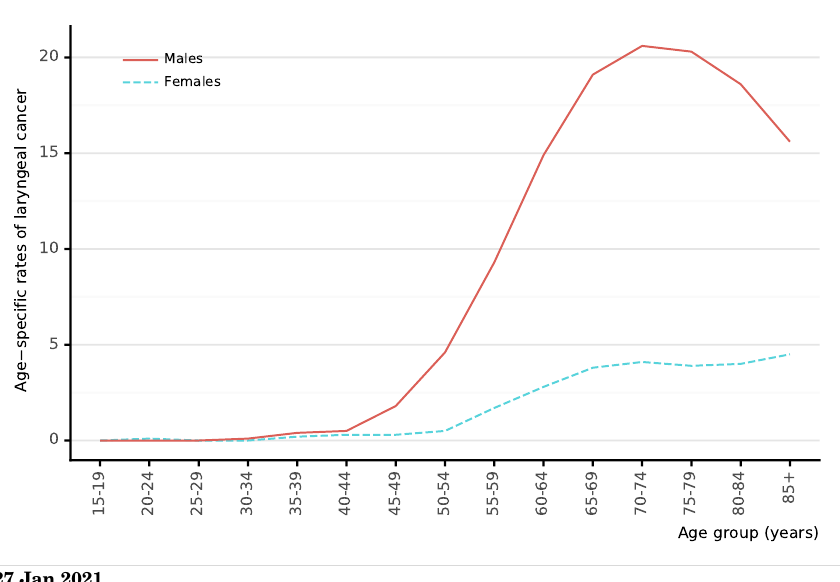
Figure 50: Age-specific mortality rates of laryngeal cancer in India (estimates for 2020)